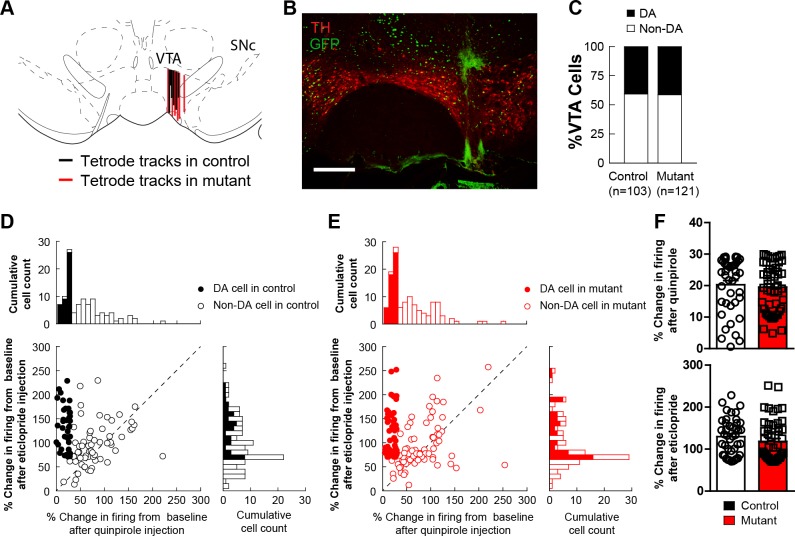
in vivo electrophysiology.(A) Schematic showing tetrode placement in controls and mutants. (B) Representative image showing placement of tetrode in the VTA for in vivo electrophysiological recordings. (C) The distribution of dopamine and non-dopamine cells recorded showed no difference between controls (n = 103) and mutants (n = 121). (D) Cumulative cell count of dopamine and non-dopamine cells in response to quinpirole (right) or eticlopride (top) or both (left) in control animals. (E) Cumulative cell count of dopamine and non-dopamine cells in response to quinpirole (right) or eticlopride (top) or both (left) in mutant animals. (F) The average change in dopamine cells in response to quinpirole (top) or eticlopride (bottom) showed no difference between controls and mutants. Bars represent mean ± SEM.